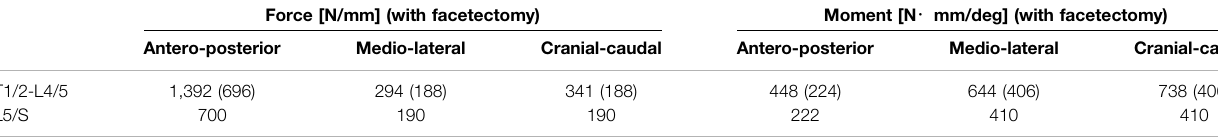
TABLE 1 | Stiffness matrix components used in this study.